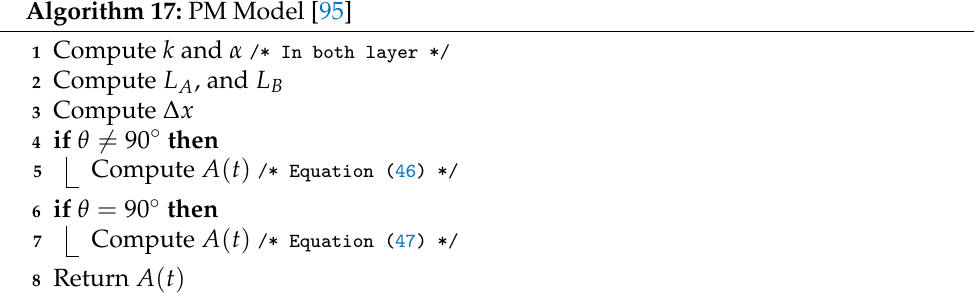
Algorithm 17: PM Model